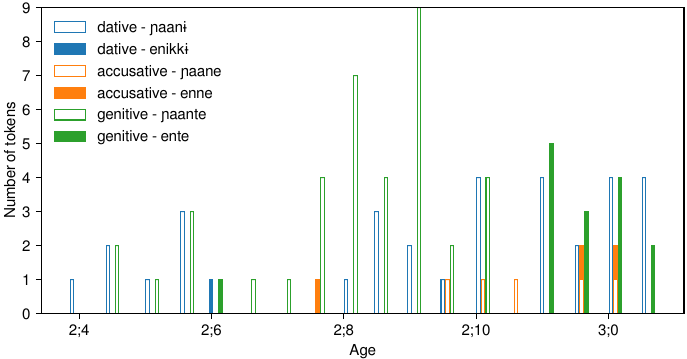
Figure 1. Pronominal stem errors in H m ’s